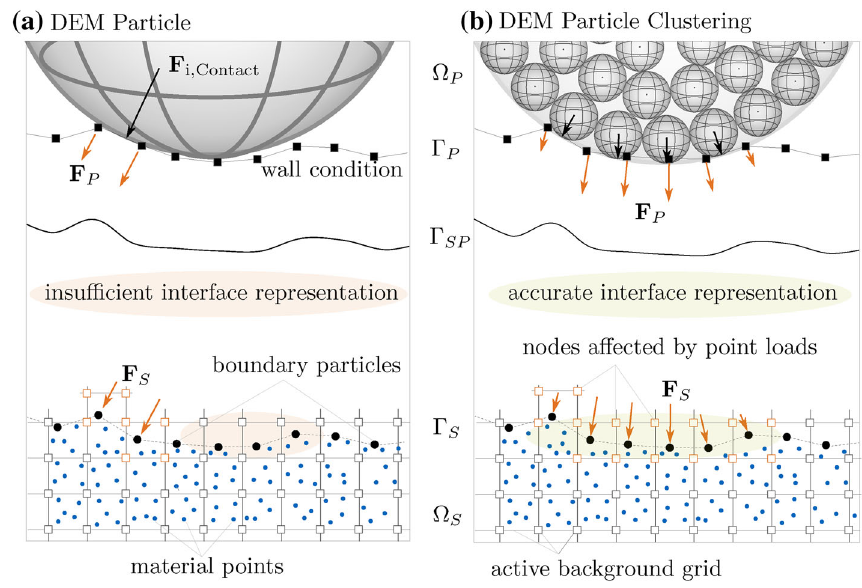
Fig. 5 Calculation of contact forces in DEM and influence of the MPM partition. a One DEM particle calculates one resulting contact force, affecting only a limited number of background grid nodes in the MPM partition. b By clustering the DEM particles, also suited for arbitrarily shaped particles, the contact forces are distributed over